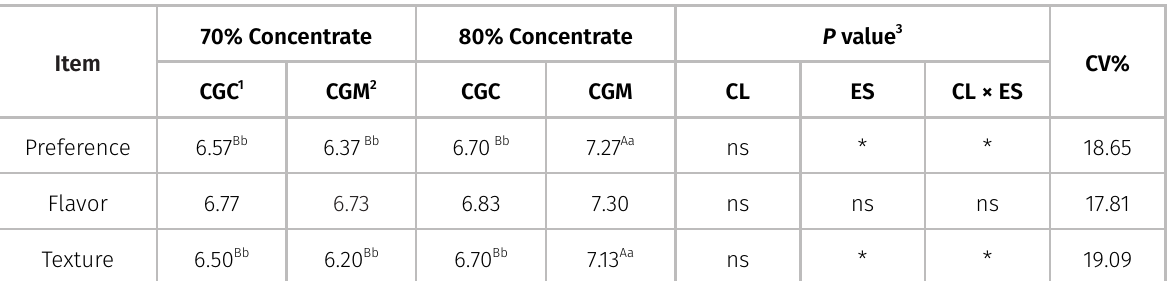
Table V. Longissimus muscle sensory characteristics of Nellore heifers fed two concentrate levels and energy